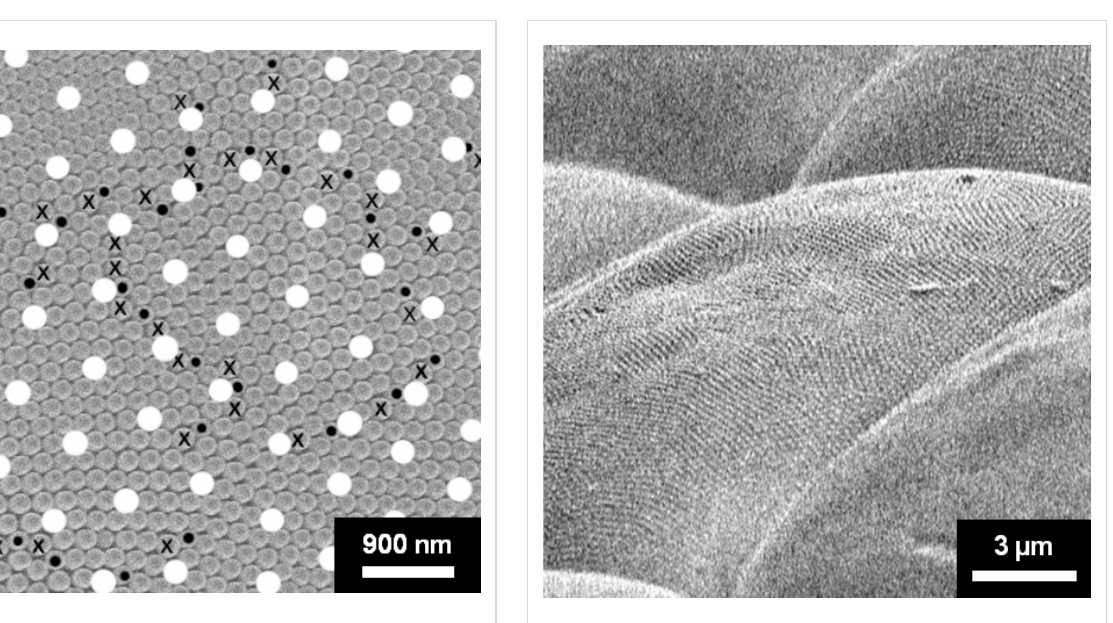
Equation 4. In other words, all 73 boundaries can be considered special boundaries.